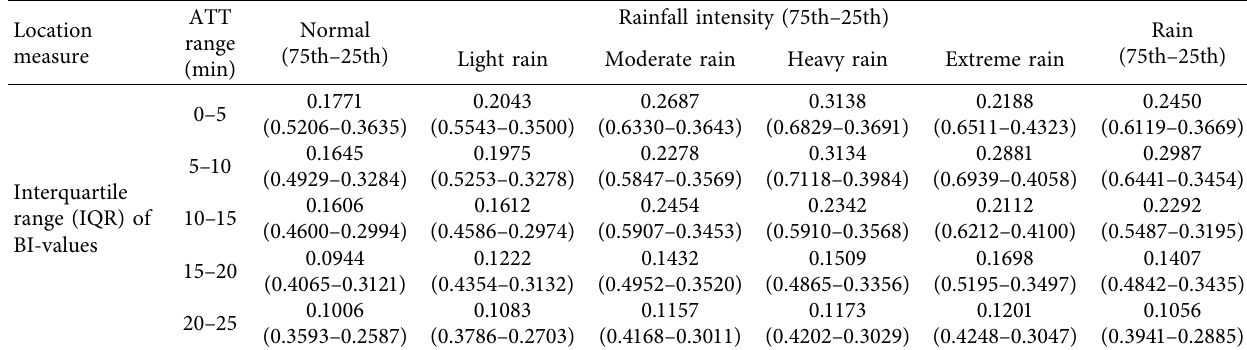
Table 7: Summary of interquartile range of BI-values under six weather conditions.